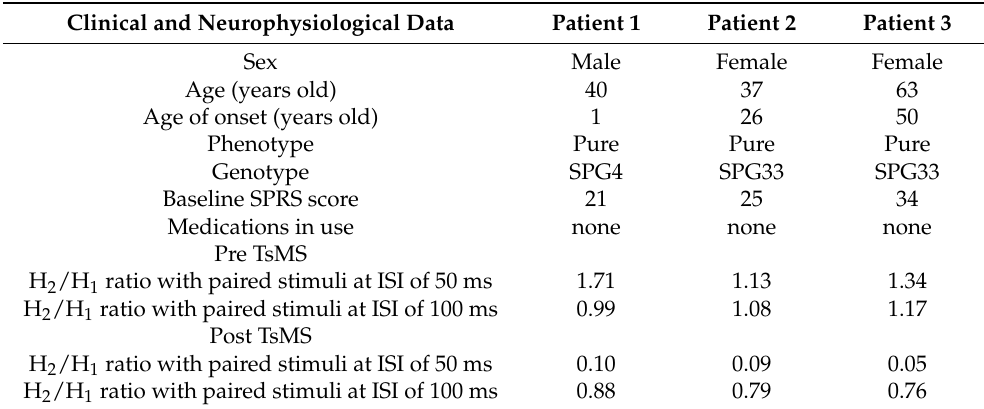
H 2 /H 1 : second H curve per first H curve ratio. ISI: interstimulus interval. ms: millisecond. SPG: spastic paraplegia. TsMS: transspinal magnetic stimulation. SPRS: Spastic Paraplegia Rating Scale.